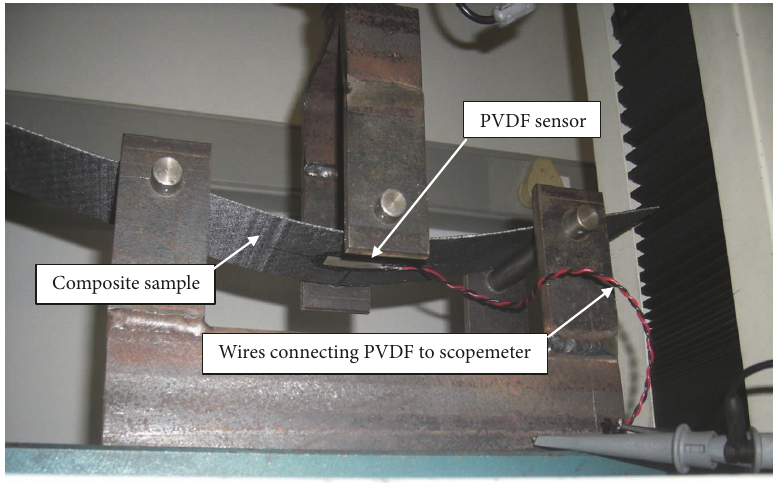
Figure 3: Three-point bending test with PVDF sensor.